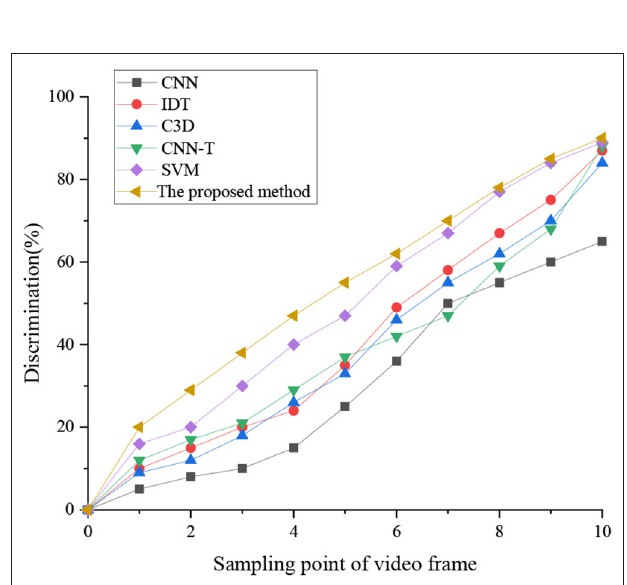
FIGURE 8 | Block diagram of feature fusion.